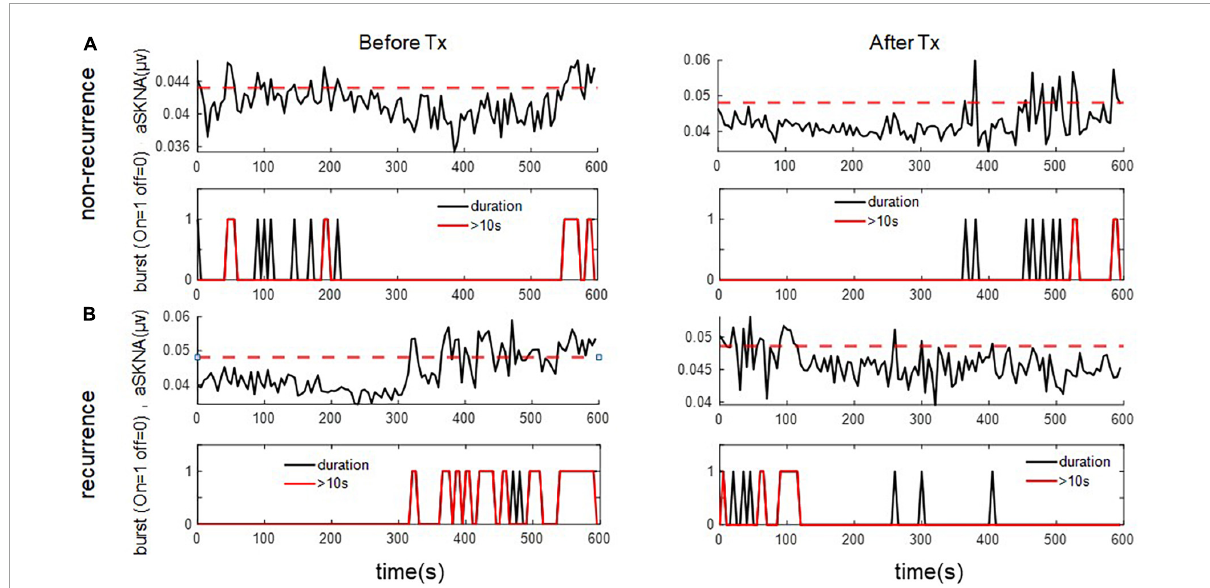
FIGURE4 The representative figure showed firing duration in a 5-s window during baseline (Before Treatment) and after ablation (After Treatment) in (A) recurred and (B) non-recurred patients. The post-ablation burst duration, esp. long duration ( > 10 s) was more frequent in the non-recurrence group. The upper panels of (A,B) represent the temporal changes of mean aSKNA (black line) and the determined threshold (red line). The lower panels of (A,B) showed the epochs with short duration of burst (black) and epochs with burst duration > 10 s